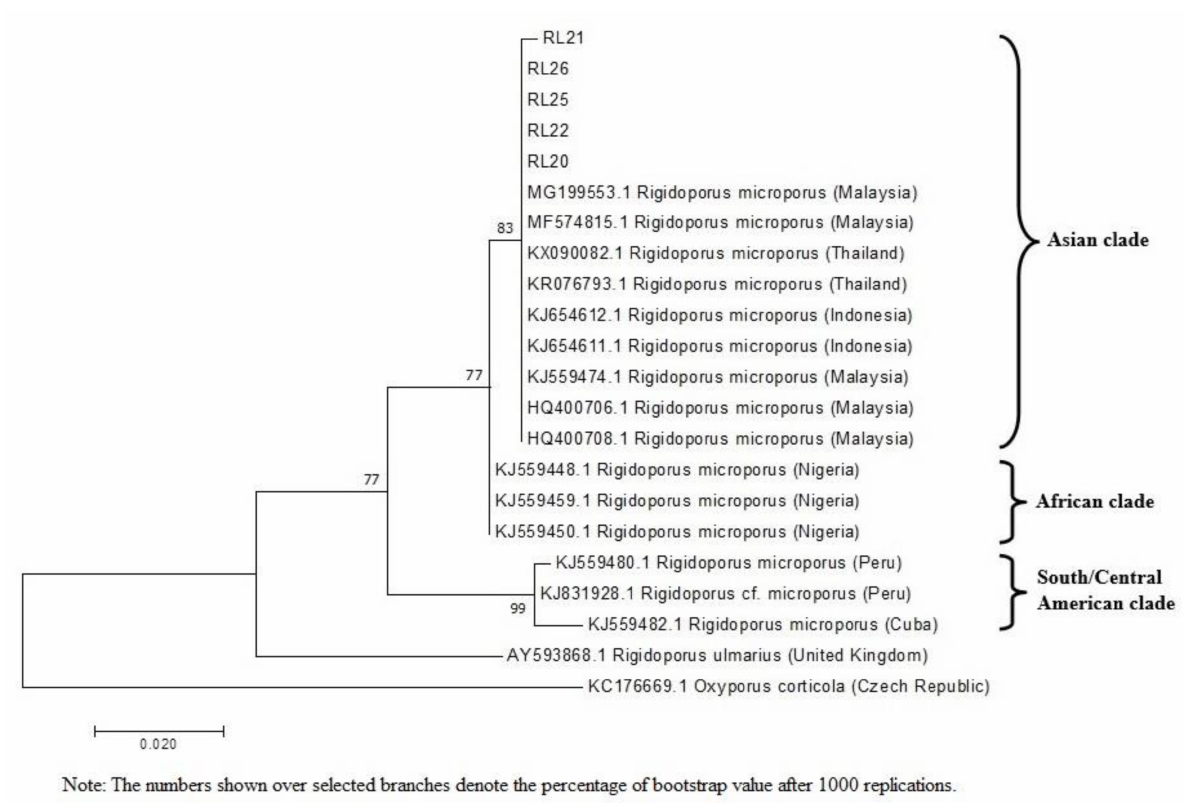
Figure 3. Evolutionary relationships based on the ITS region of the genomic rRNA gene of sixteen Rigidoporus isolates and one outgroup search derived from maximum likelihood analysis, showing the relationship between the five R. microporus isolates obtained with other closely related isolates and